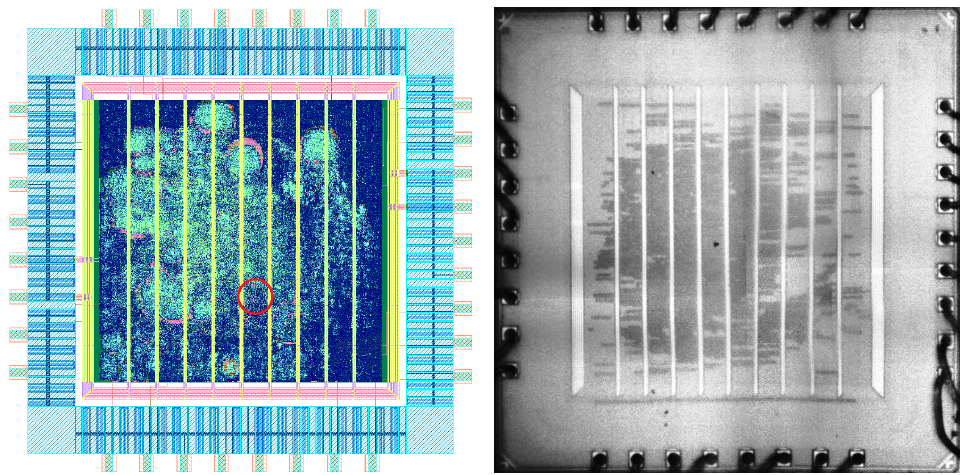
Figure 4: Layout schematic of the 40 nm ASIC on the left and microscope photography of the fabricated chip on the right.